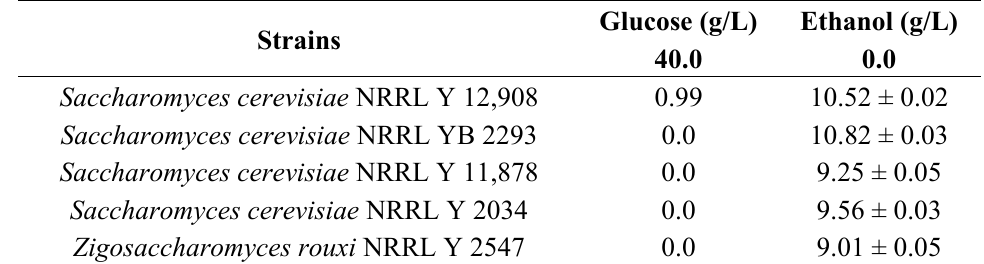
Table 1. Glucose and ethanol concentration after 72 h of fermentation in synthetic medium of the yeast species strains. Data represent the mean of two independent